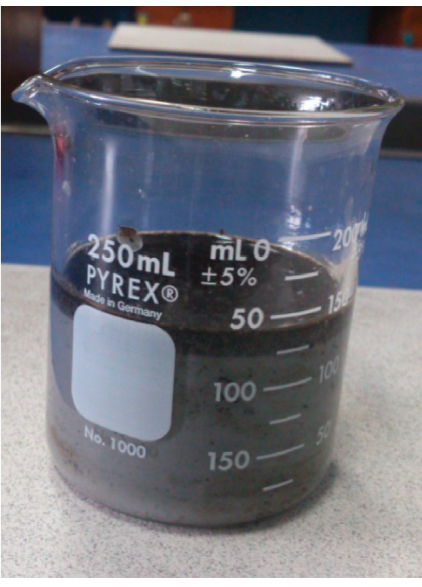
Figure 1: Industrial cutting fluid